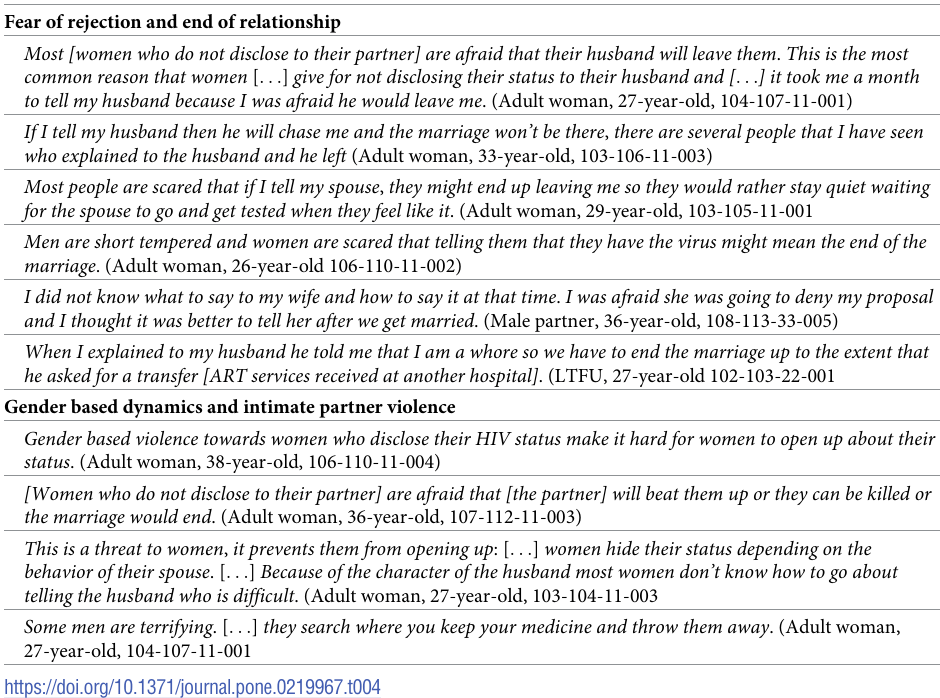
Table 4. Main reasons for non-disclosure within couples.